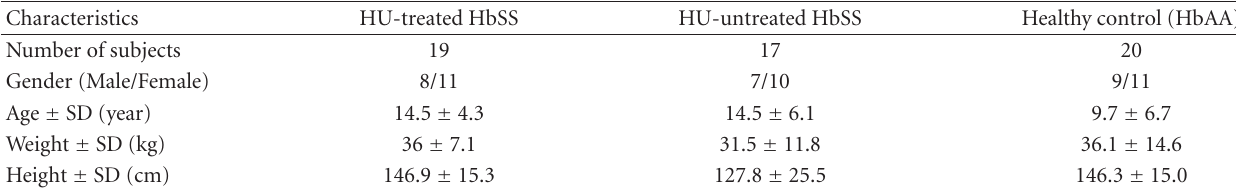
Table 1: Characteristics of the HU-treated and untreated HbSS patients and healthy (HbAA) subjects. Characteristics